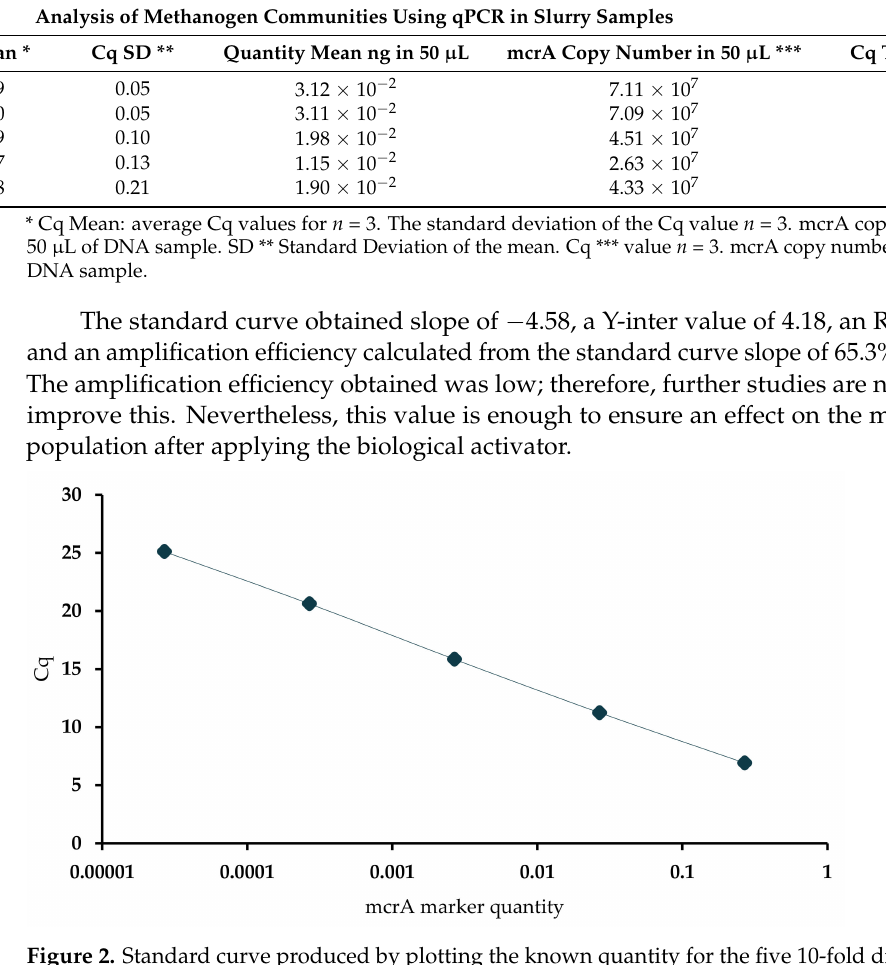
Figure 2. Standard curve produced by plotting the known quantity for the five 10-fold dilution series of the first treated sample for the mcrA marker versus their Cq values.